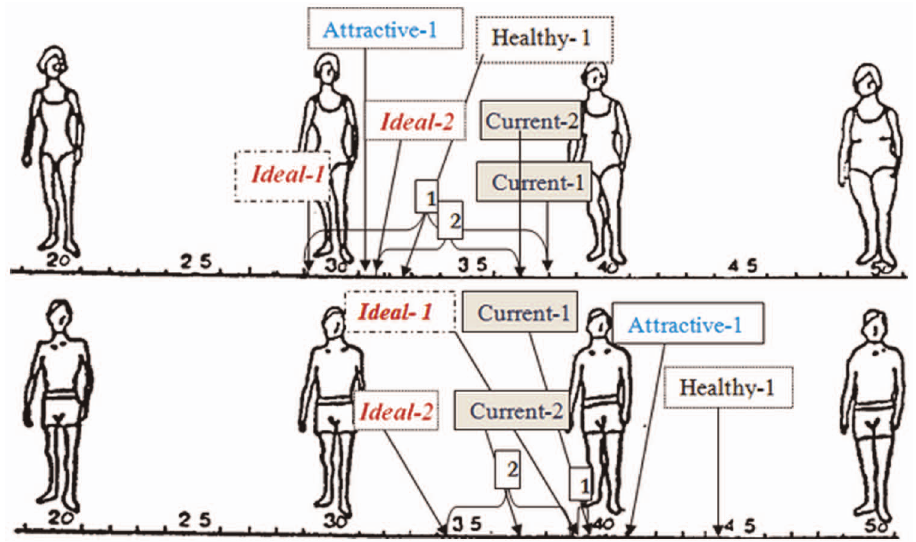
Figure 3. Mean and standard deviations of body figures rating of adolescents: girls (top) boys (bottom).